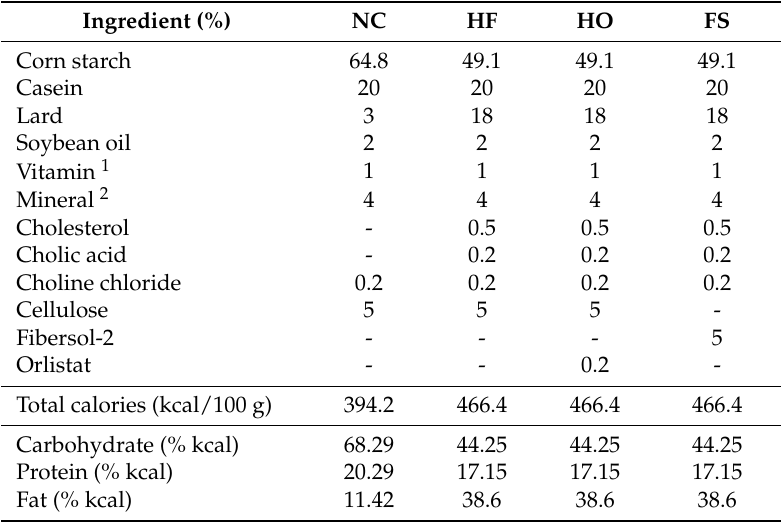
Table 1. Composition of experimental diets